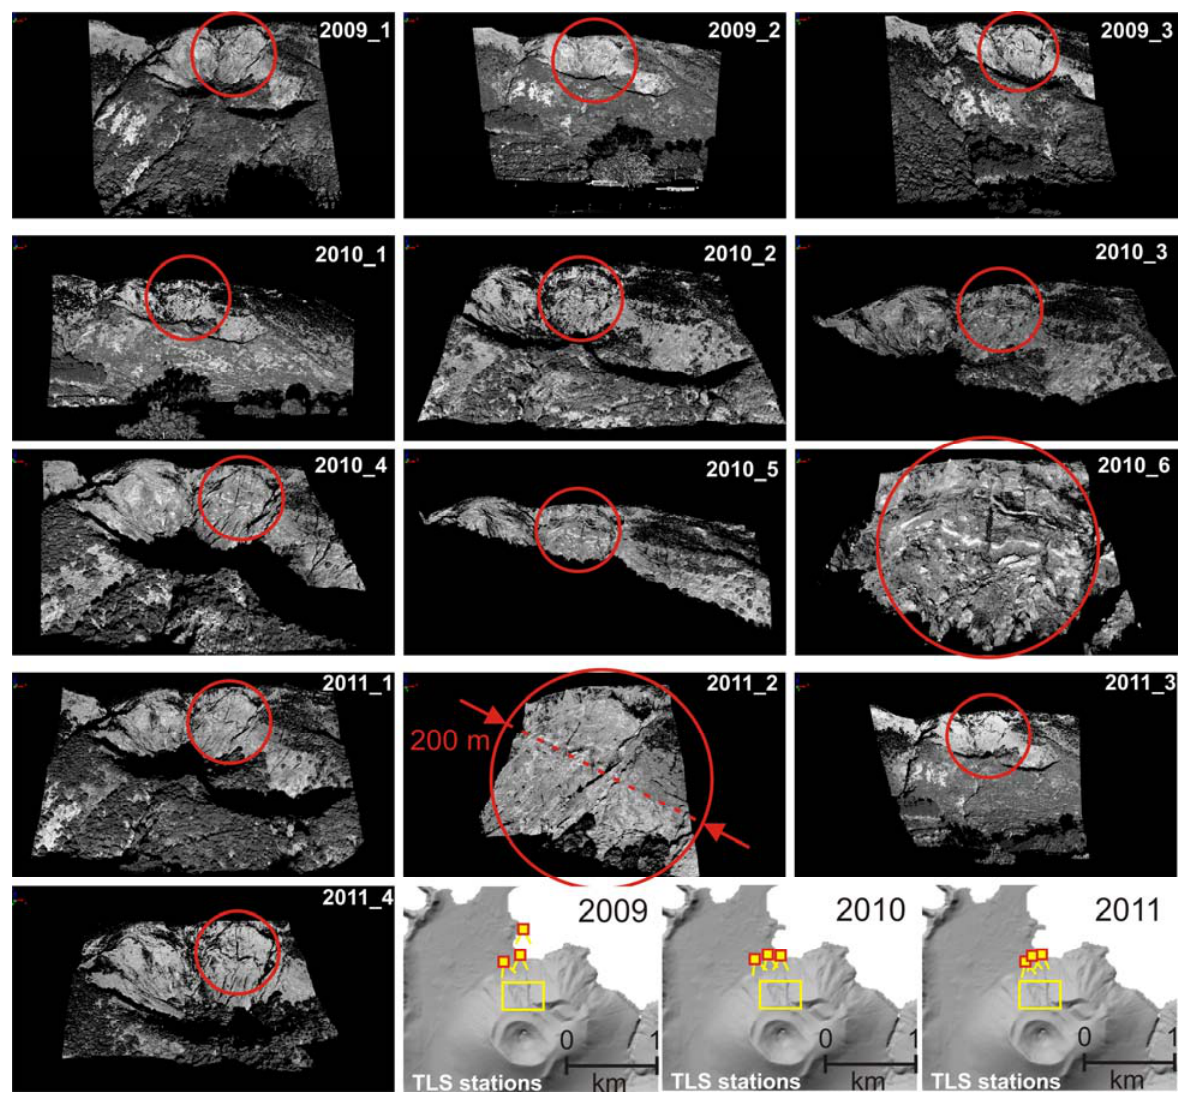
Figure 2. Point clouds acquired in 2009, 2010 and 2011 by means of TLS. Red circles indicate the investigated area, whose mean radius is about 200 m. The lower panels show the monitored area (yellow rectangle) with respect to the Vulcano Island DTM and the viewpoints for the TLS observations. Each point cloud is provided in to a relative reference frame related to the instrument position. Please note that only in 2009 survey one acquisition was obtained from a distance longer than 1 km; since the results were not suitable for a correct analysis, the point was no more used in the next measurement